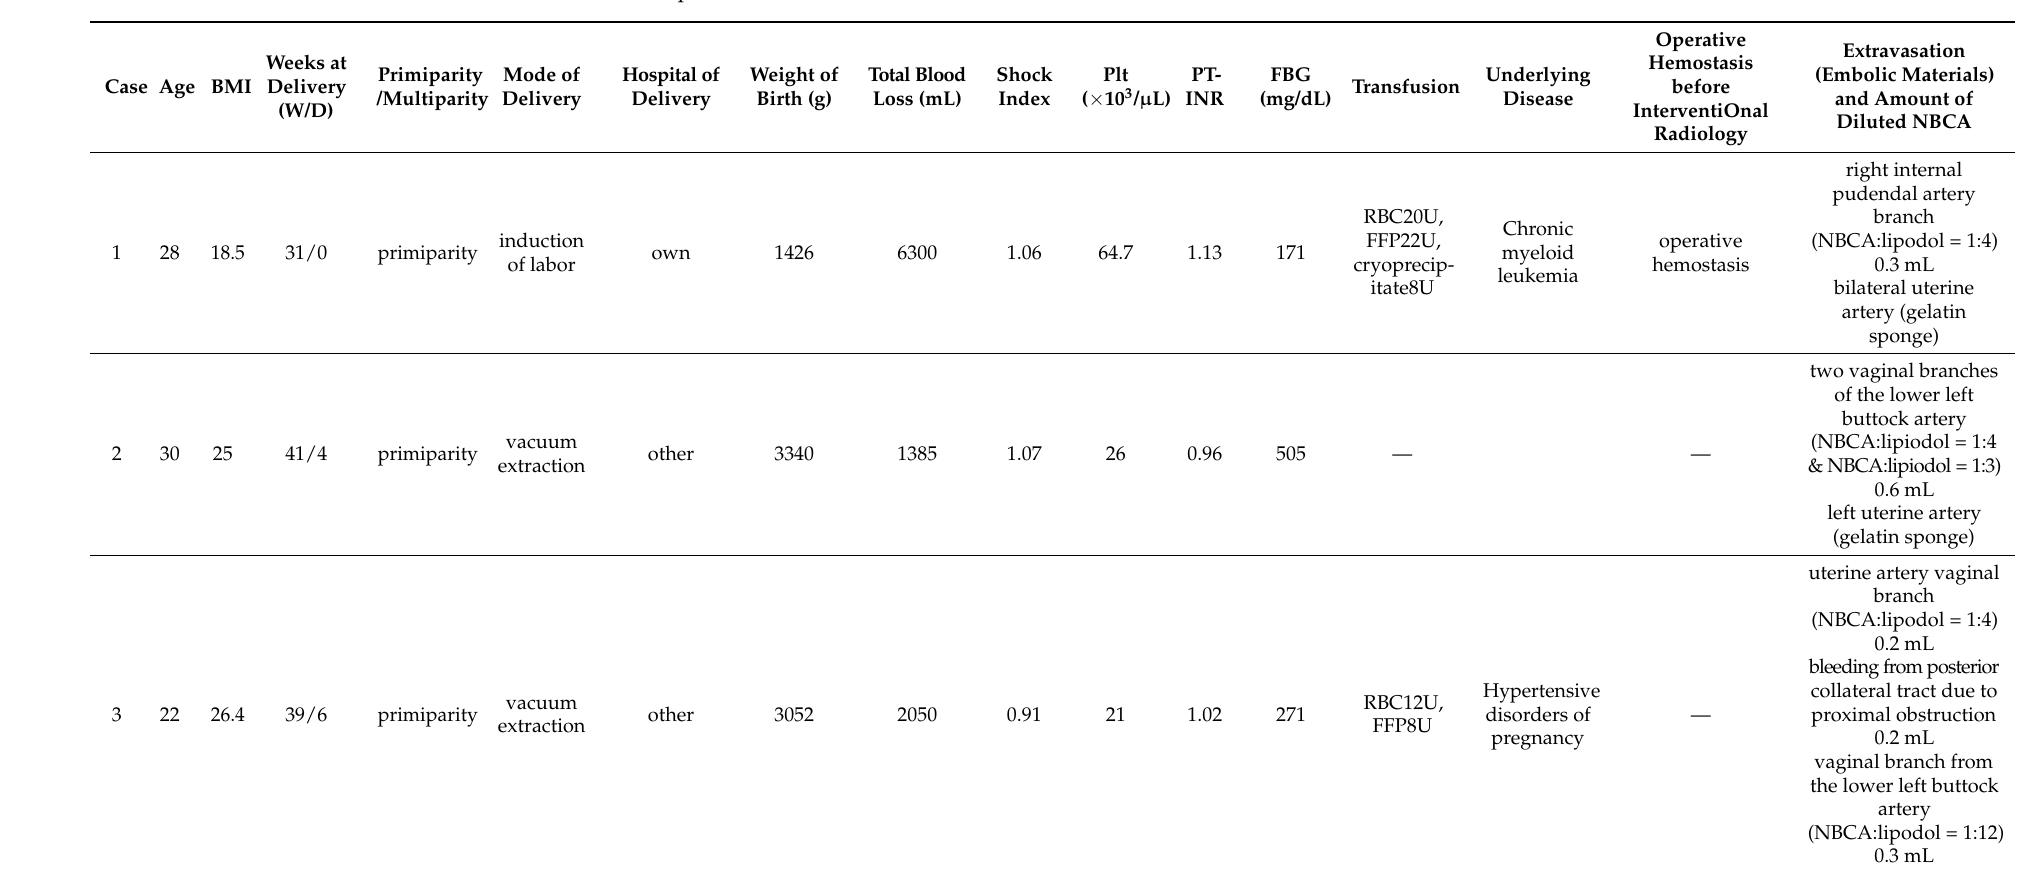
Table 1. Characteristics of